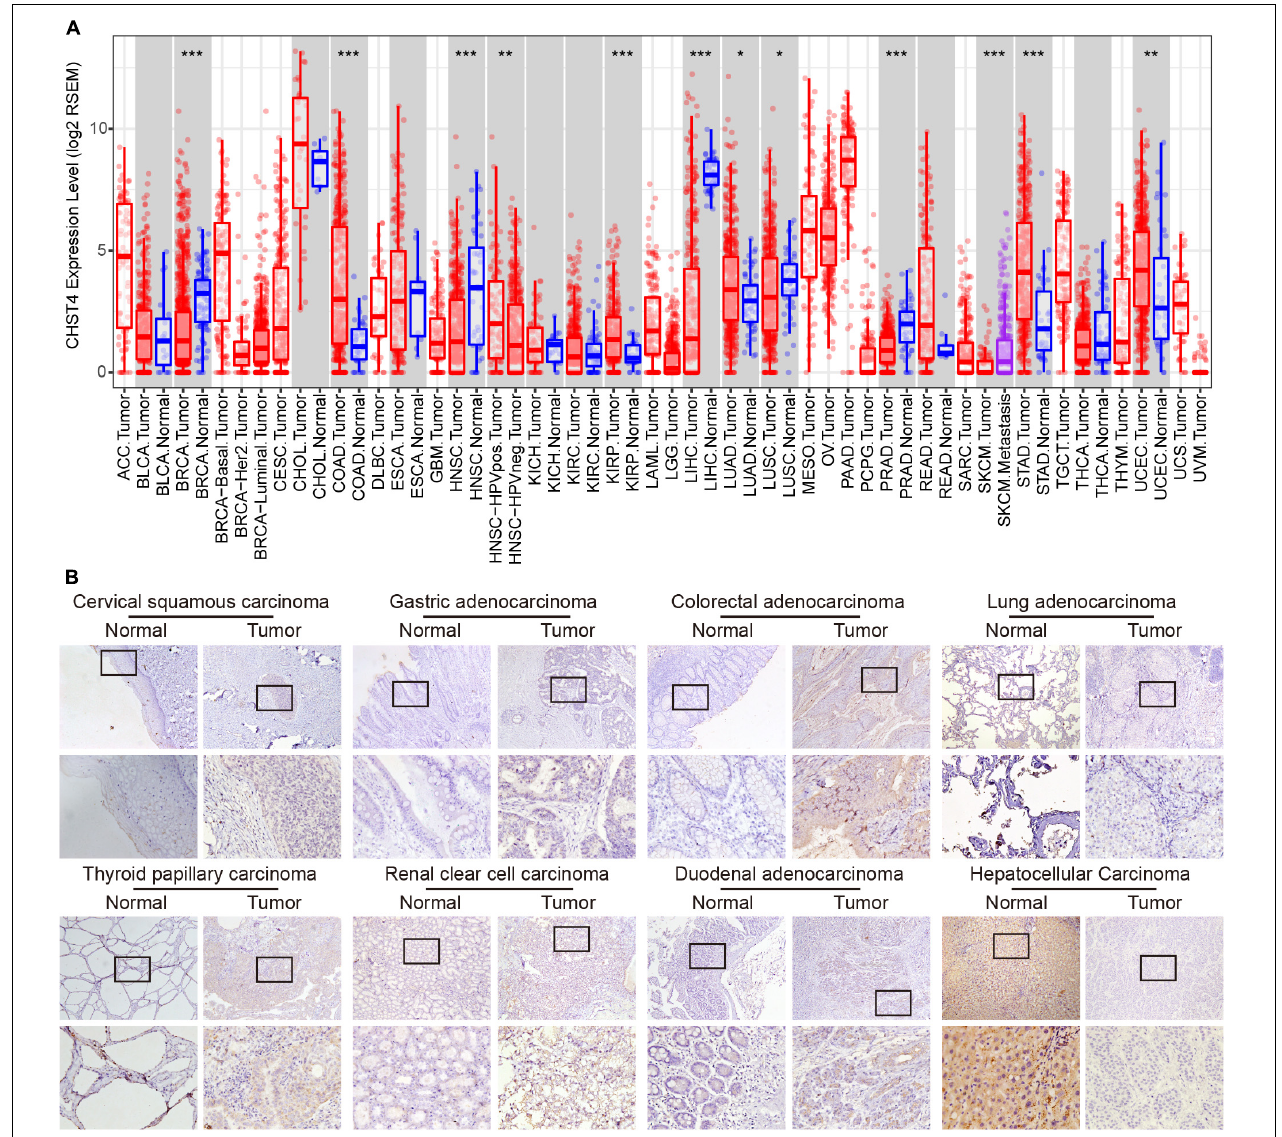
FIGURE 2 | Expression, copy number, and gene alteration of CHST4 in human tumors. (A) mRNA expression of CHST4 in 34 types of human tumors, alone or with their paired normal tissues from the TIMER platform. Bars represent mean ± SD; * P < 0.05, ** P < 0.01, *** P < 0.001 (Student’s t -test).588896101588896101 (B) Immunohistochemical analysis of the expression and distribution of CHST4 proteins in human tissues (100 × ; 400 × ; more than three samples in each